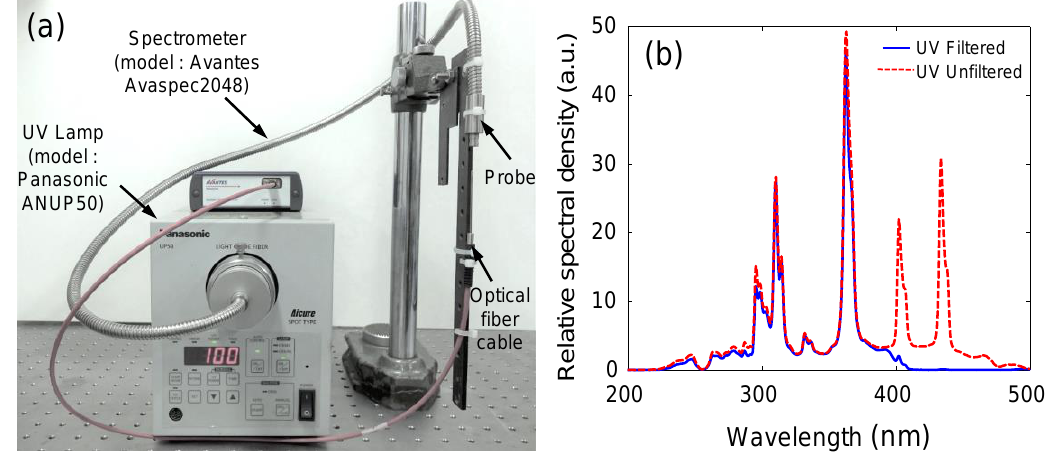
Figure 5. UV light source for experiment: ( a ) UV lamp and spectrometer and ( b ) spectral responses.